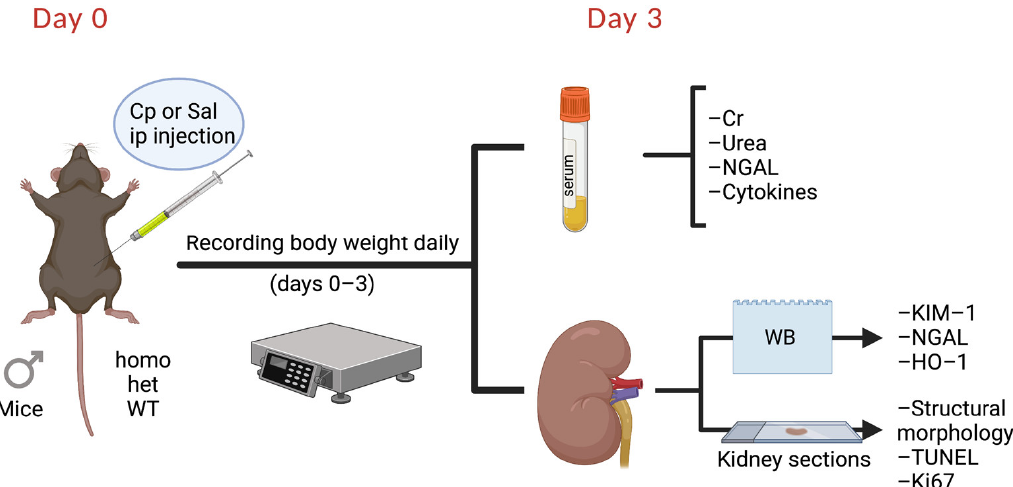
Figure 7. Experimental timeline. Cp, cisplatin; Cr, creatinine; het: heterozygous knockout for GPER1 gene; HO-1, heme oxygenase-1; homo, homozygous knockout for GPER1 gene; KIM-1, kidney injury molecule 1; NGAL, neutrophil gelatinase-associated lipocalin; Sal, saline; TUNEL, Terminal deoxynucleotidyl transferase-mediated dUTP nick-end labeling; WB, Western blotting; WT, wild-type. Created with BioRender.com.